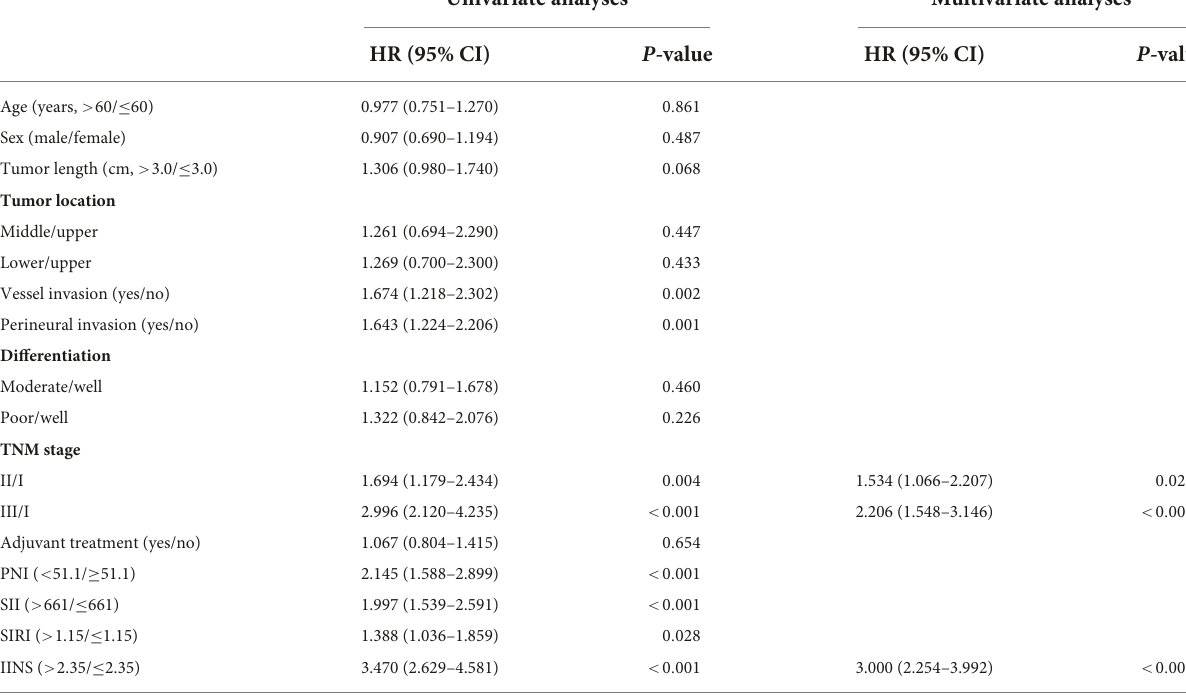
TABLE 3 Univariate and multivariate Cox analyses of cancer-specific survival (CSS) in training set. Univariate analyses Multivariate analyses